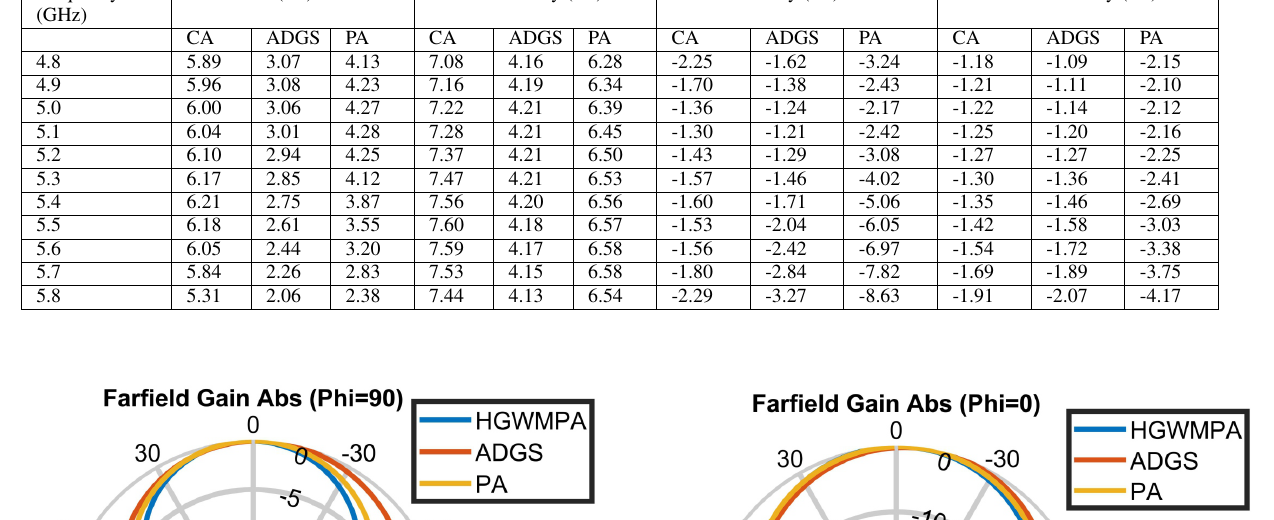
TABLE 3. Gain, directivity and efficiencies of PA, ADGS and HGWMPA/CA at various frequencies Frequency (GHz)